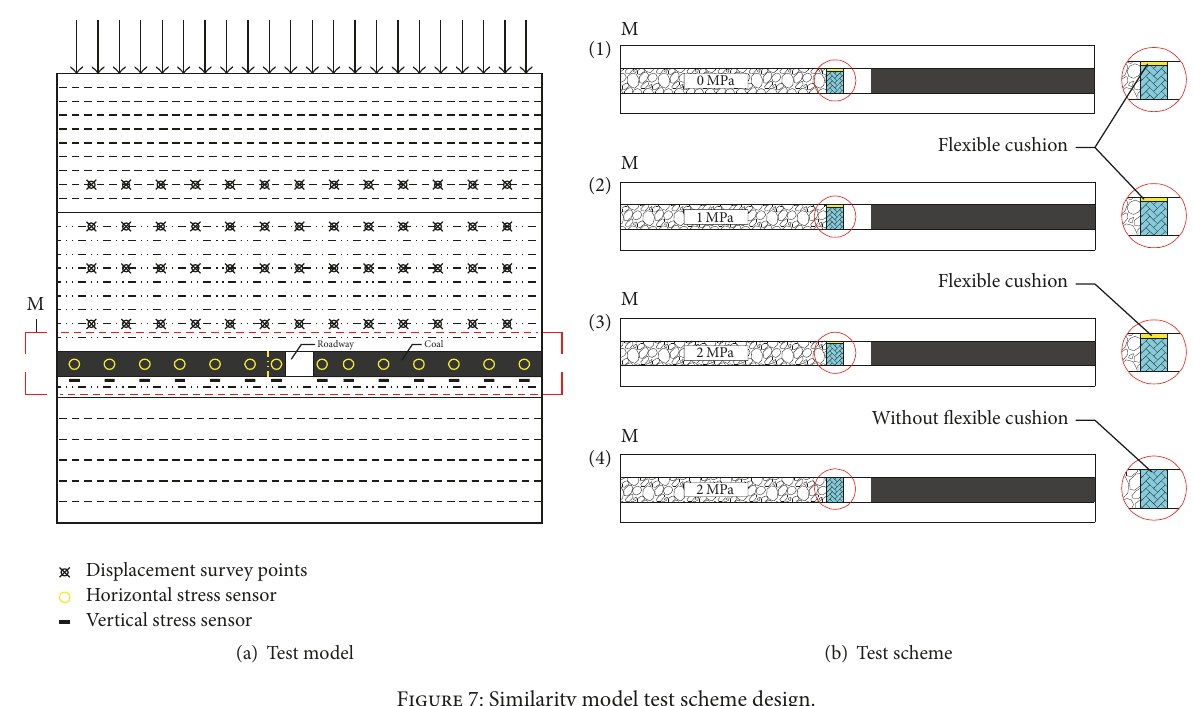
Figure 7: Similarity model test scheme